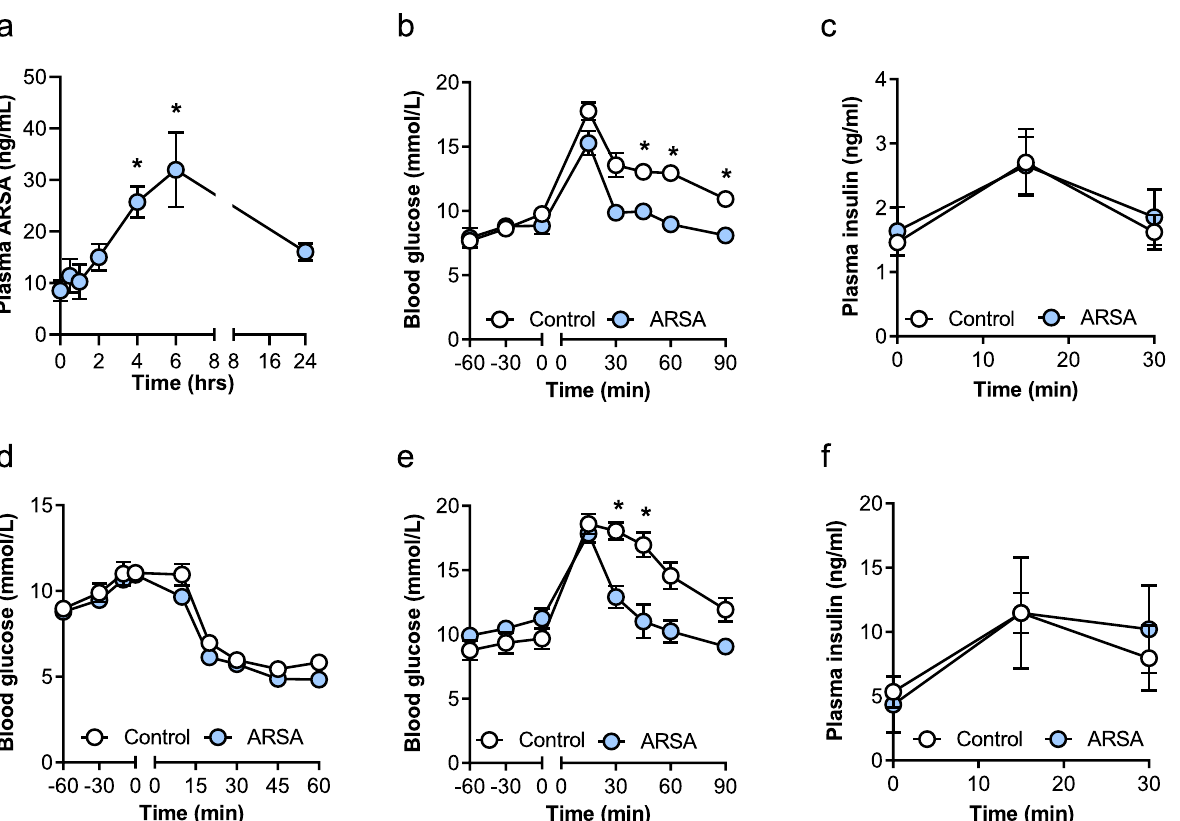
Fig. 3 Acute recombinant ARSA administration improves glycemic control. Male mice were injected with recombinant ARSA (1 mg/kg body weight) followed by metabolic assessment an hour later. a Plasma ARSA concentration before (0 min) and after recombinant ARSA injection ( n = 5), * P =